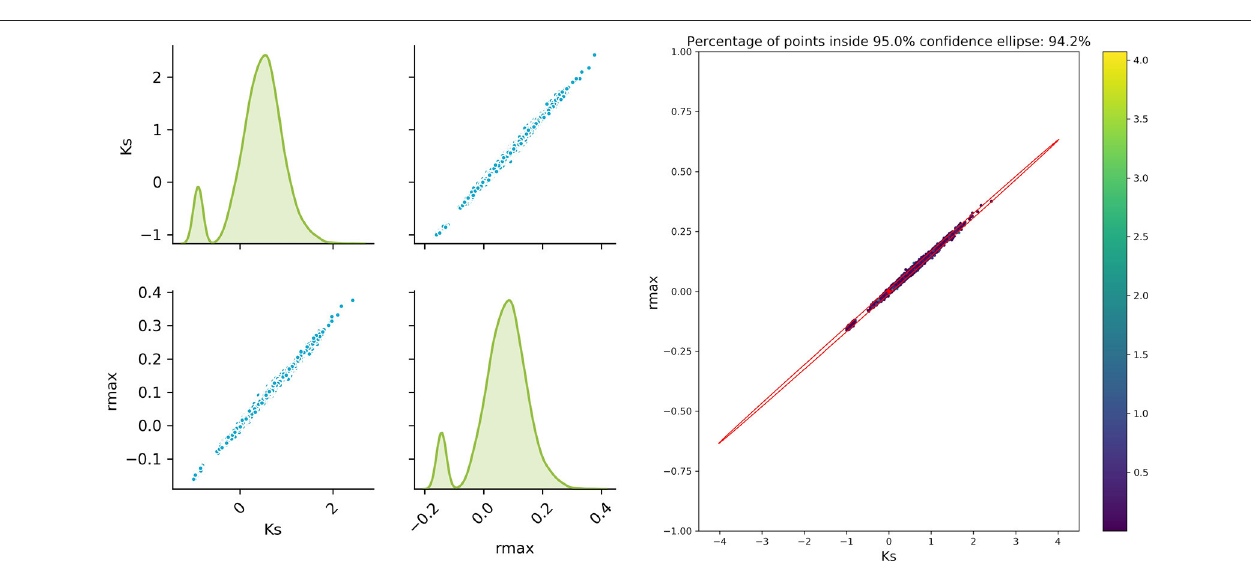
FIGURE 3 | Monte Carlo results for t bad ; Left : pair plots of parameters obtained with a data noise using µ = 0 and σ 2 = 0.16; Right MC vs. FIM.